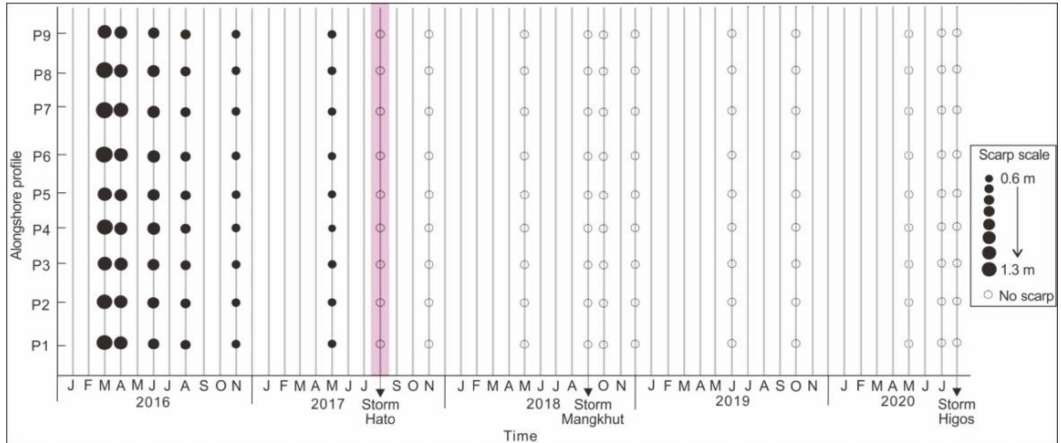
Figure 8. Temporal distribution of scarp occurrence and absence along ML beach. Grey vertical lines show the temporal variation in months while lines inlayed with circles highlight the conducted field surveys. Solid circles indicate beach scarp presence with their radius representing scarp height, while hollow circles represent beach scarp absence. Pink band highlights the period in which scarps are removed fully from ML